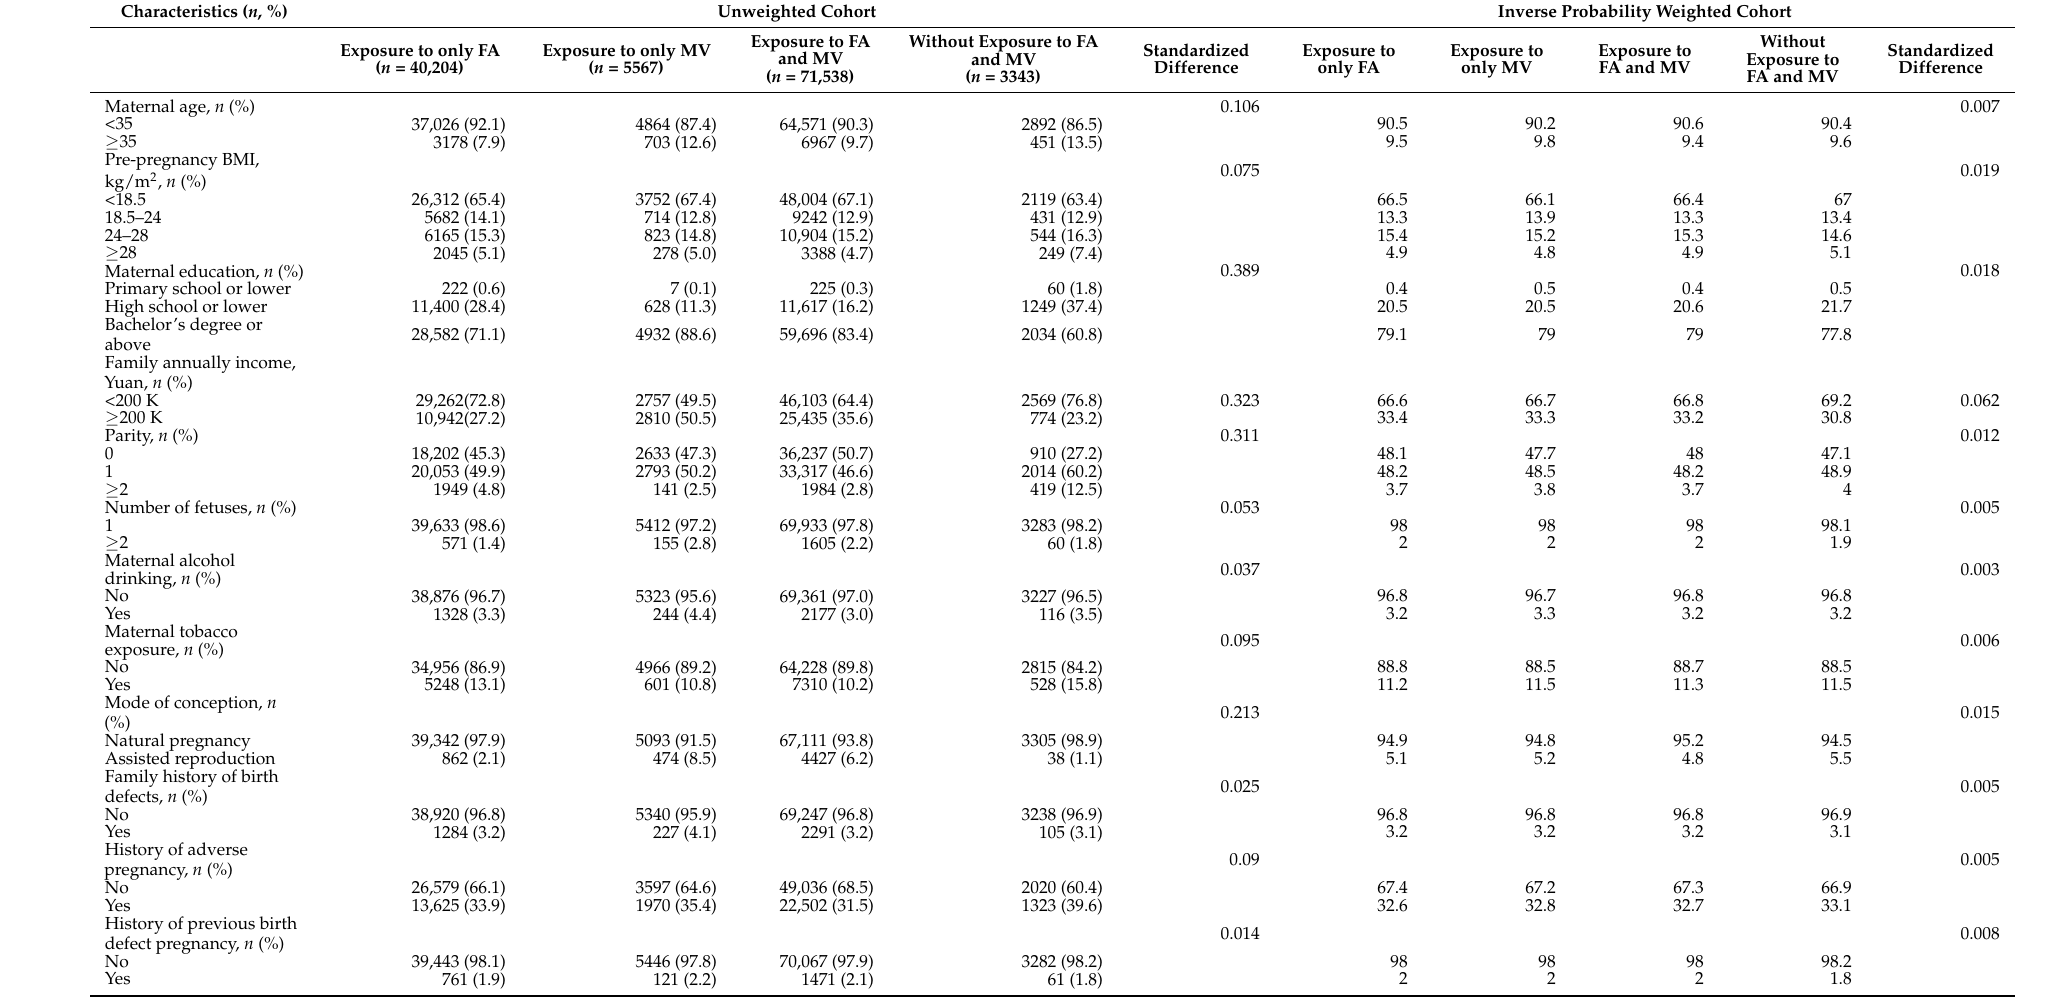
Table 1. Demographics and characteristics of